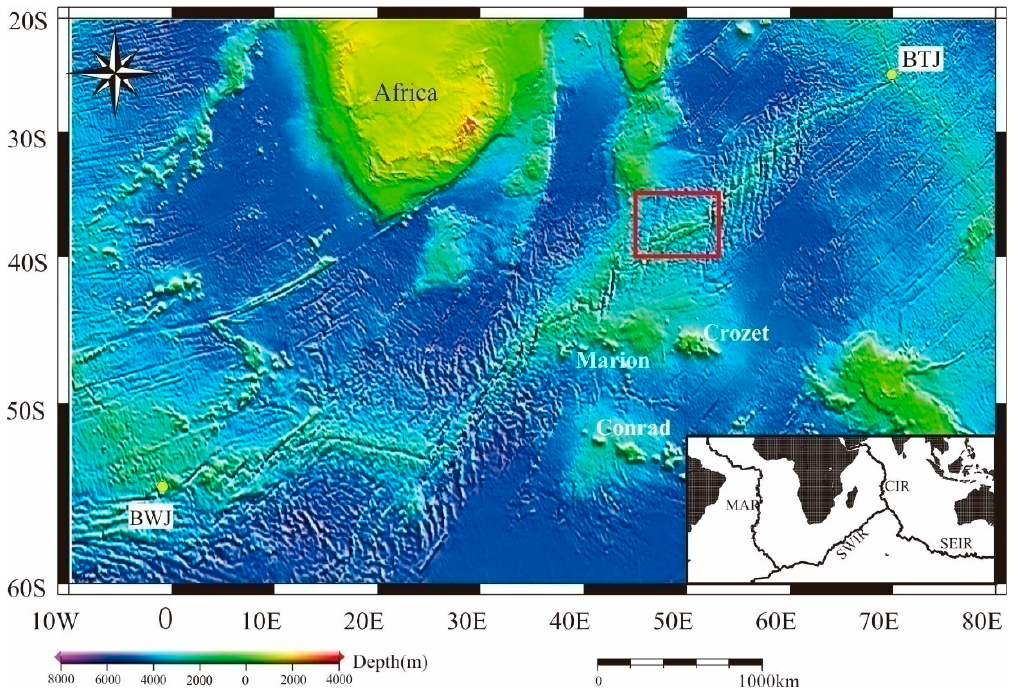
Figure 1. The study area in the central eastern part of the Southwest Indian Ridge (SWIR), ~900 km north of the Crozet hotspot ， the red box indicates the range of the study area.